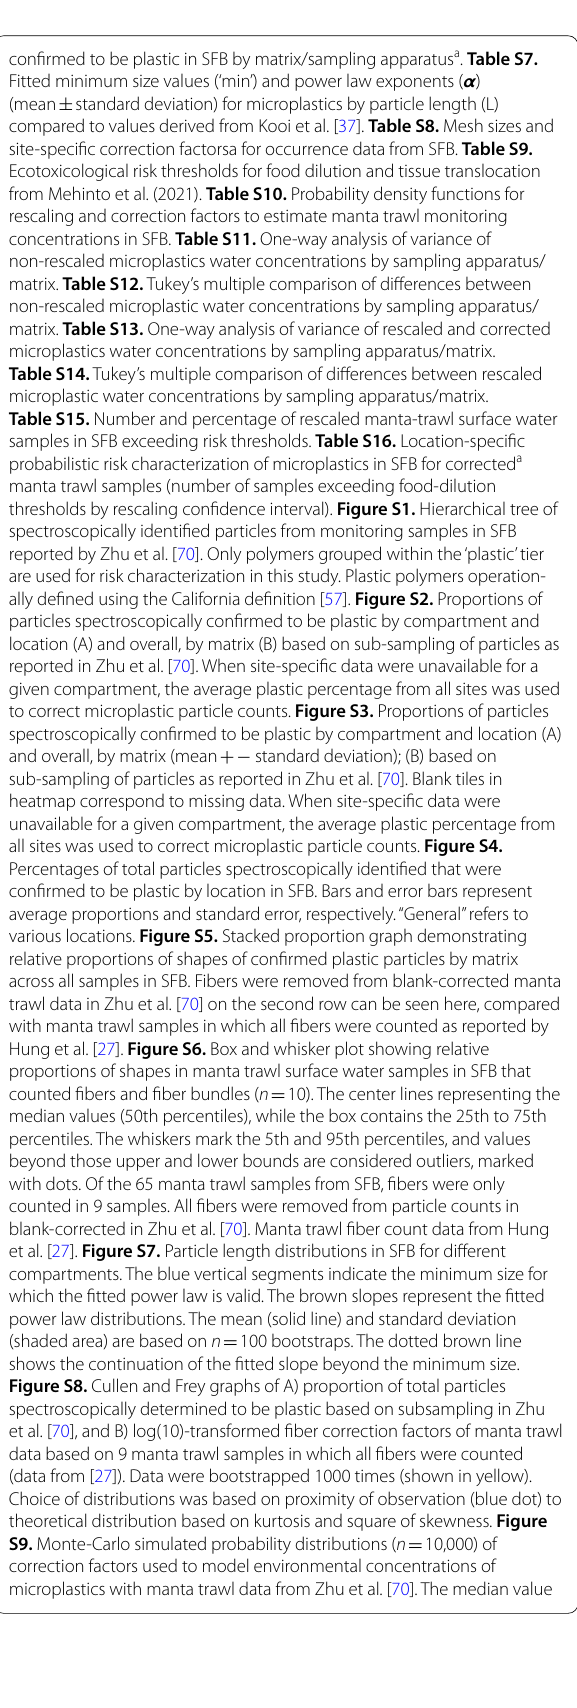
confirmed to be plastic in SFB by matrix/sampling apparatus a . Table S7. Fitted minimum size values (‘min’) and power law exponents ( 𝞪 ) (mean standard deviation) for microplastics by particle length (L) ± compared to values derived from Kooi et al. [37]. Table S8. Mesh sizes and site-specific correction factorsa for occurrence data from SFB. Table S9. Ecotoxicological risk thresholds for food dilution and tissue translocation from Mehinto et al. (2021). Table S10. Probability density functions for rescaling and correction factors to estimate manta trawl monitoring